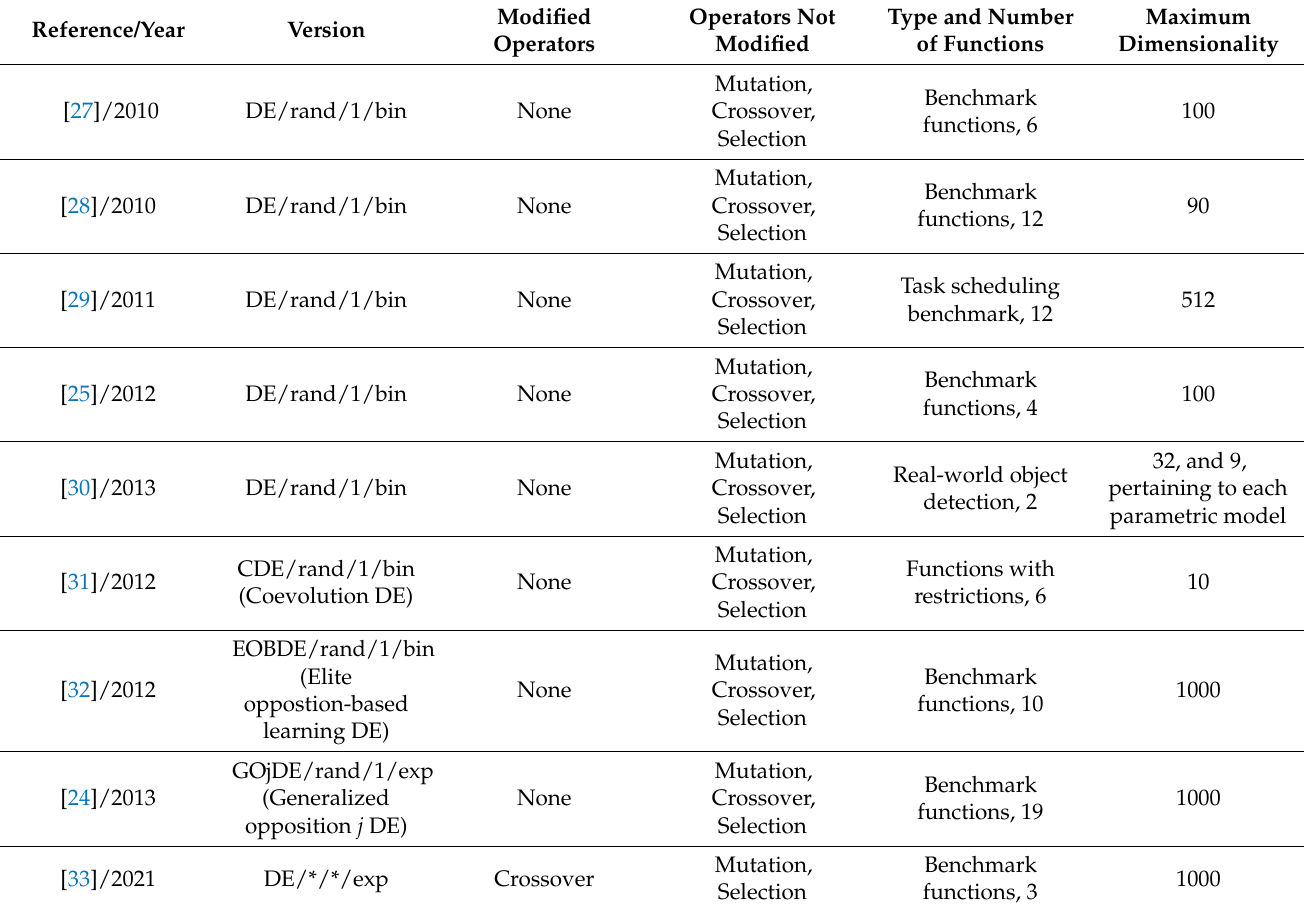
Table 1. GPU differential evolution implementation